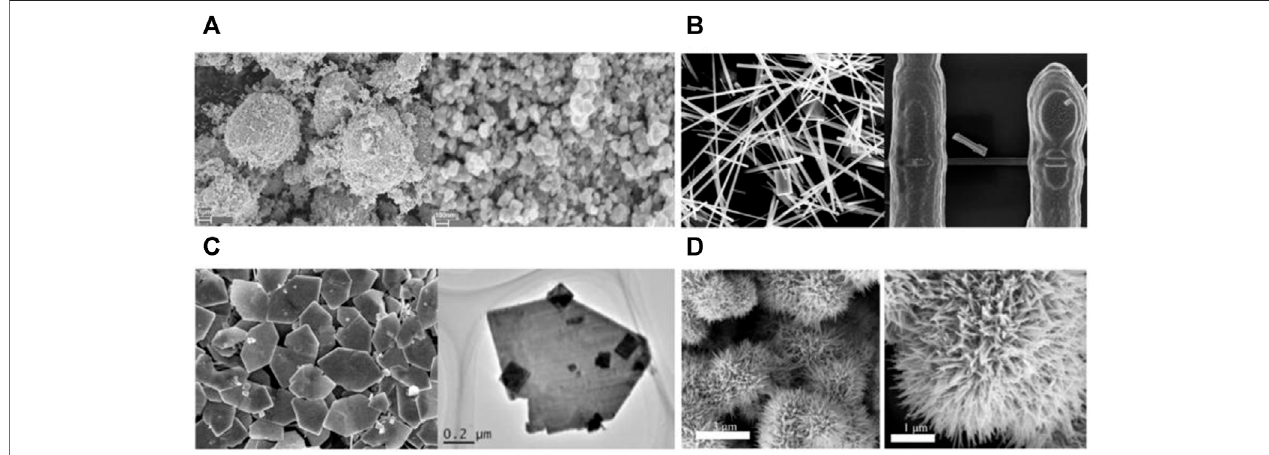
FIGURE 3 | The microstructure of h-WO 3 nanoparticle, nanowire, fi lm, and nanosphere (A) 0D h-WO 3 nanoparticle (Szilágyi et al., 2010). (B) 1D h-WO 3 nanowire (Liu et al., 2014). (C) 2D h-WO 3 fi lm (Meng et al., 2015). (D) 3D h-WO 3 nanosphere (Zhang et al., 2019).